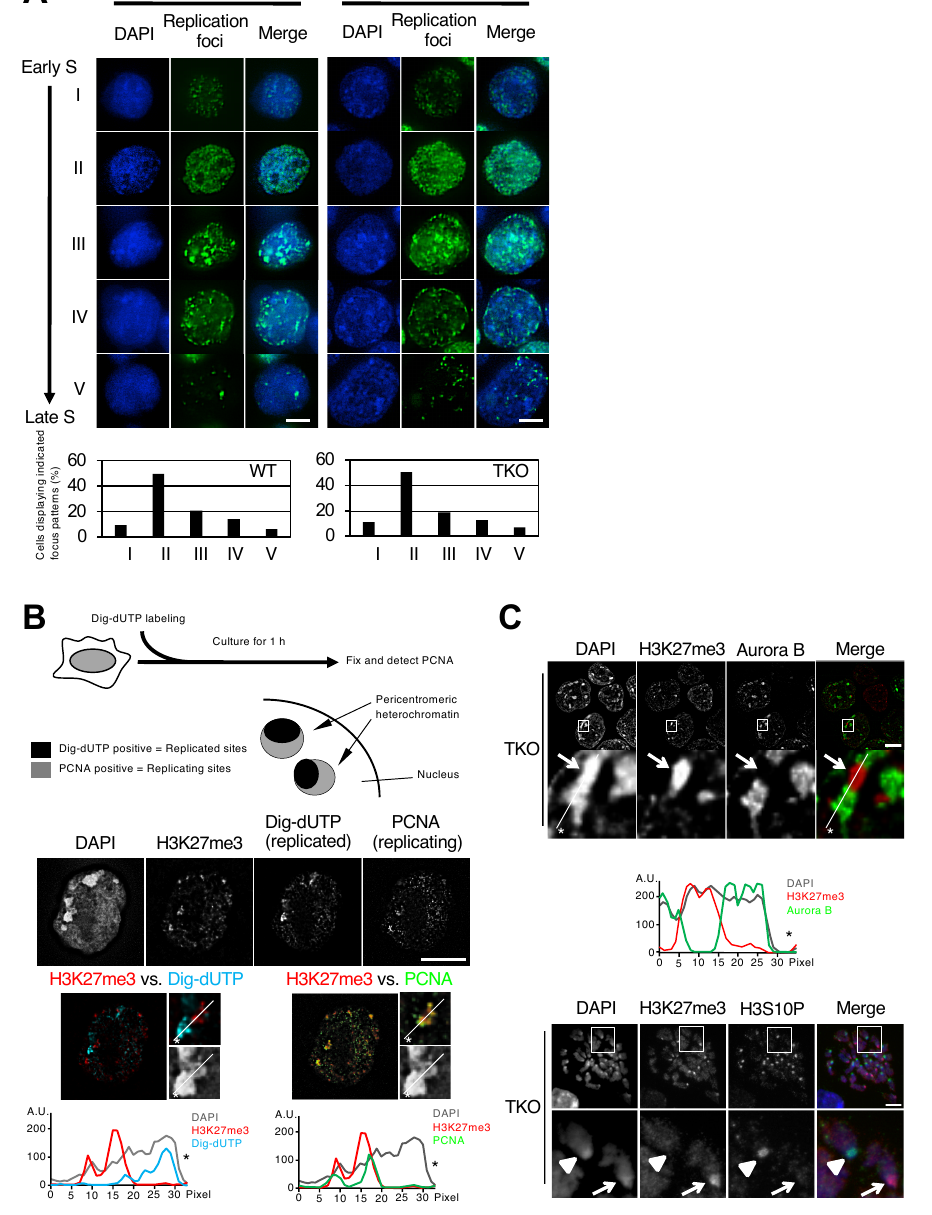
Figure 1. H3K27me3 foci formed in mouse embryonic stem cells with severely hypomethylated DNA coin- cide with later replication of pericentromeric heterochromatin. ( A ) Spatial regulation of DNA replication sites in Dnmt1 − / − Dnmt3a − / − Dnmt3b − / − triple-knockout (TKO) mouse embryonic stem (ES) cell nuclei during S phase. Asyn- chronously growing cells were labeled with EdU (green) for 10 min to visualize sites of DNA synthesis in the nucleus. Five representative images of the distribution patterns of DNA replication foci during S phase over time (I–V) are shown [40,41]. Nuclear DNA was stained with DAPI (blue). The percentage of cells displaying each focus pattern was scored ( n > 200). ( B ) The top panel shows the experimental strategy used to determine the temporal order of replication within pericen- tromeric heterochromatin (PH) regions of TKO ES cells where abnormal H3K27me3 foci were formed. Unsynchronized cells were first labeled with DIG-dUTP, cultured for 1 h, and then fixed for PCNA/H3K27me3 immunostaining. Both DIG-dUTP-positive and PCNA-positive PH were selected to measure colocalization with H3K27me3 foci. During the 1 h